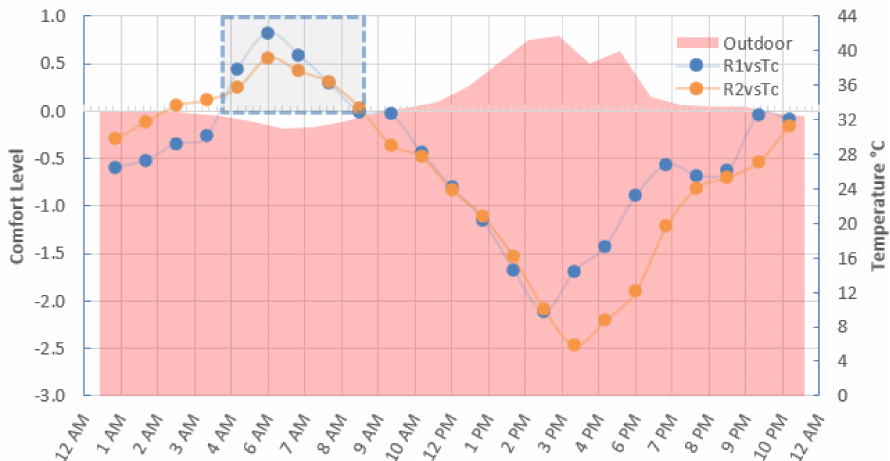
Figure 22. The hourly outdoor temperature and room temperature profiles of 29 August compared to the comfort